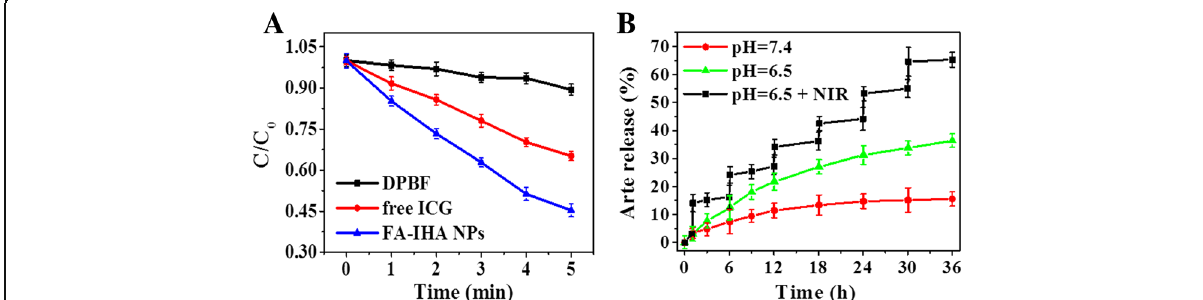
Fig. 4 a Normalized DPBF absorbance in the presence of ICG, FA-IHA NPs, and blank sample under 808 nm laser irradiation (1 W/cm 2 ). b Release kinetics of Arte from FA-IHA NPs under pH = 7.4 and pH = 6.5 with or without NIR laser irradiation,